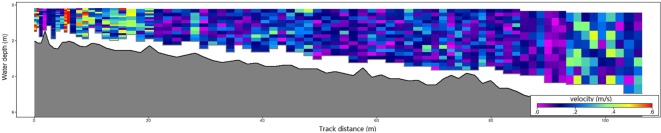
The current velocity in the east bank of the transection.